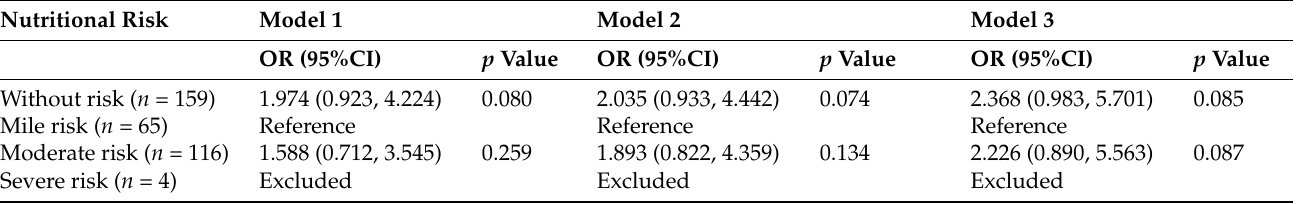
Table 4. Associations of different levels of nutritional risk with risk of depression in patients after acute ischemic